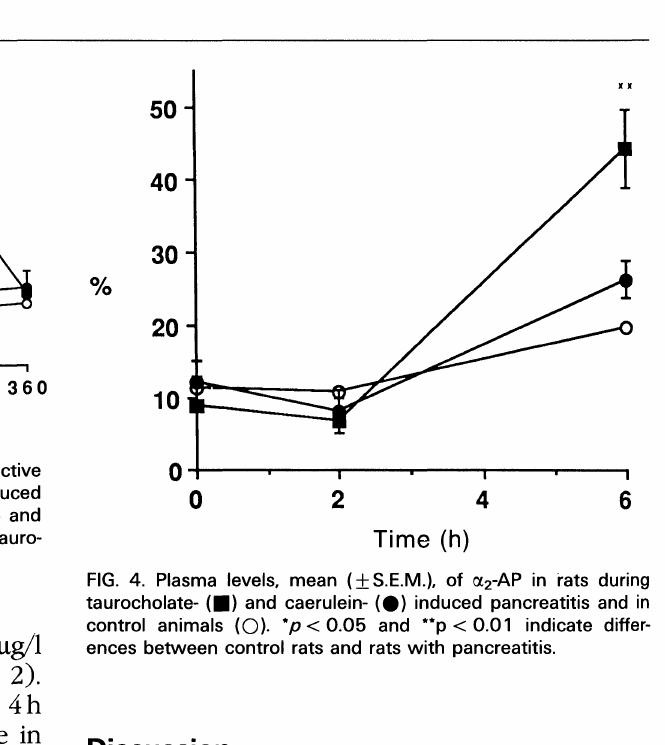
FIG. 2. Dialysate levels, mean (_S.E.M.), of immunoreactive bradykinin during taurocholate- (.) and caerulein- (t)) induced pancreatitis in rats, compared with controls ((C)). *p < 0.05 and **p< 0.01 indicate differences between control and tauro- cholate rats.